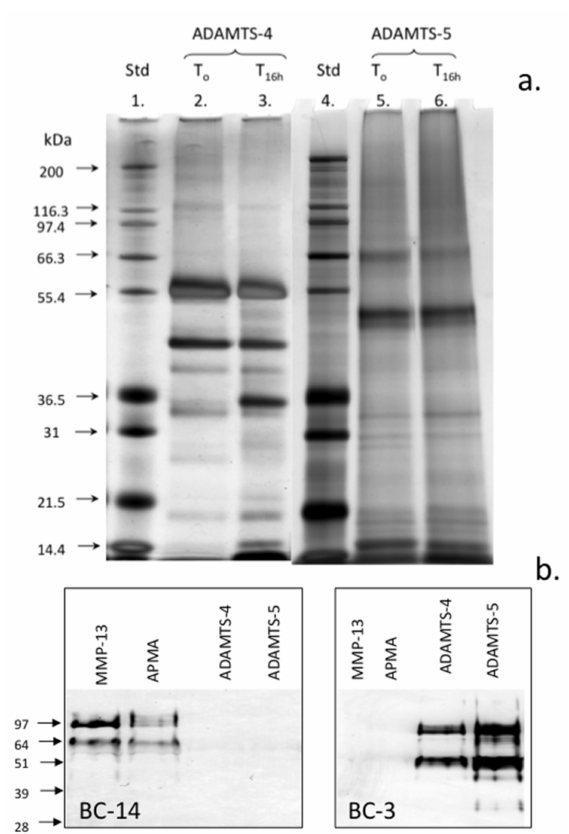
Figure 5. Assessment of the autocatalytic conversion of ADAMTS-4 and ADAMTS-5 in vitro. The silver-stained lithium dodecyl sulphate polyacrylamide gel electrophoresis (LDS PAGE) gel of the ADAMTS-4 and ADAMTS-5 species present following activation for 16 h. The samples of ADAMTS-4, -5 were incubated at 37 ◦ C in MMP digestion buffer and the aliquots were removed after time zero and 16 h incubation at 37 ◦ C and were then analyzed in pre-poured Bis-Tris 10% NuPAGE gels (0.5 µ g/lane) electrophoresed in 3-(N-morpholino) propanesulfonic acid (MOPS) running buffer. The gels were stained with a Novex Silver Stain kit to visualize ADAMTS species ( a ). Western blots demonstrating the generation of the BC-14 MMP neoepitope by MMP-13 digestion of human articular cartilage and generation of the BC-3 aggrecanase neoepitope in aggrecan by the activated ADAMTS-4 and ADAMTS-5 preparations ( b ). Broad range protein molecular weight standards (Novex) were used in lanes 1 and 4 for size calibrations and SeeBlue-2 pre-stained standards for the Western blots. This experiment was repeated twice and similar results were